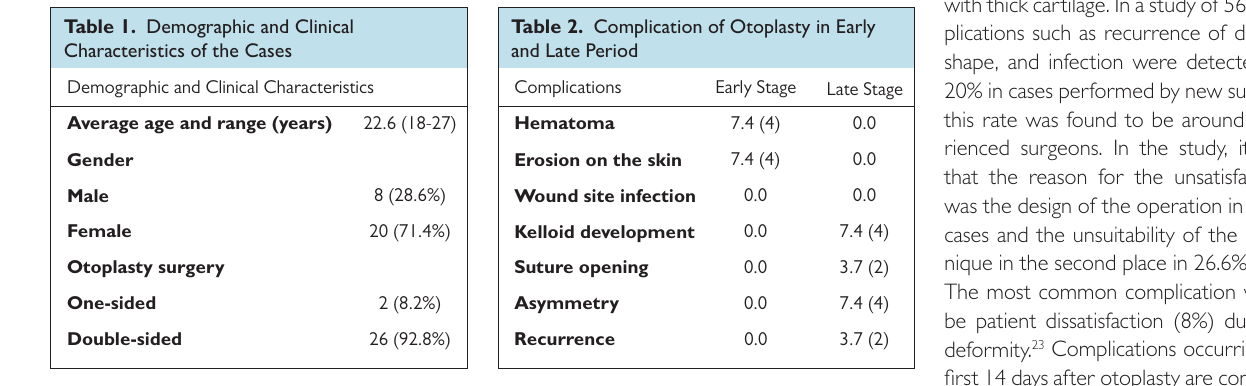
Figure 3. Horizontal mattress suturing with 5/0 polypropylene monofilament suture.